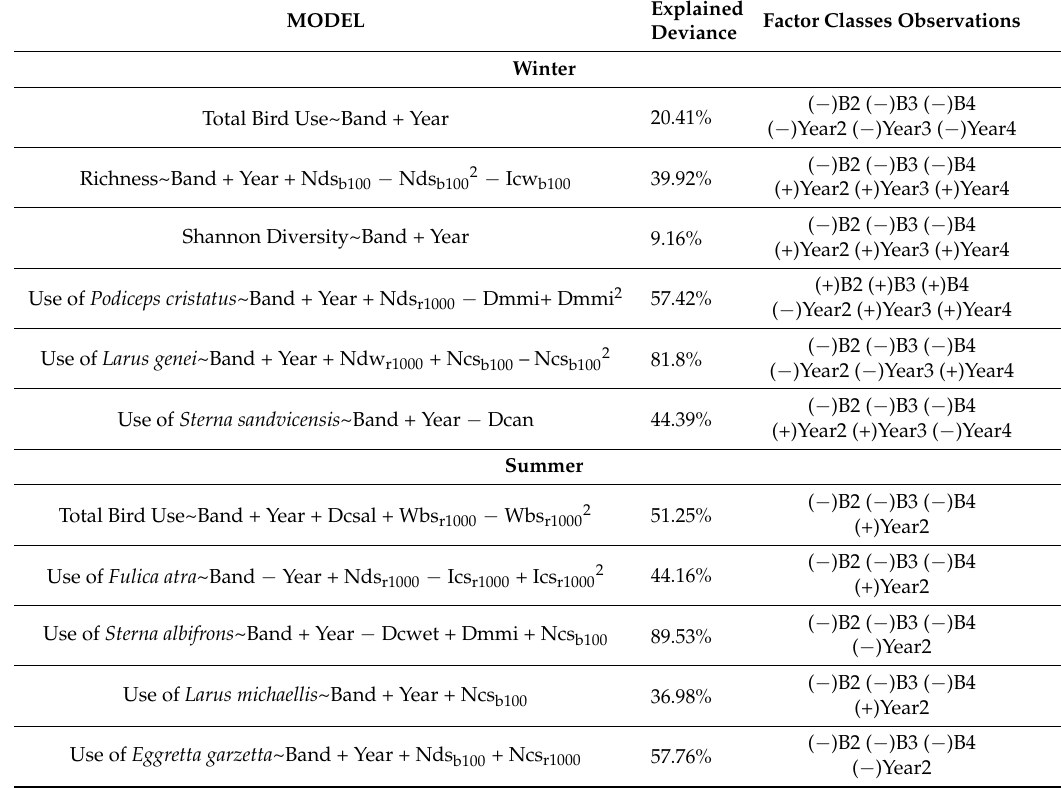
Table 5. Multiple regression models of indices and indicator